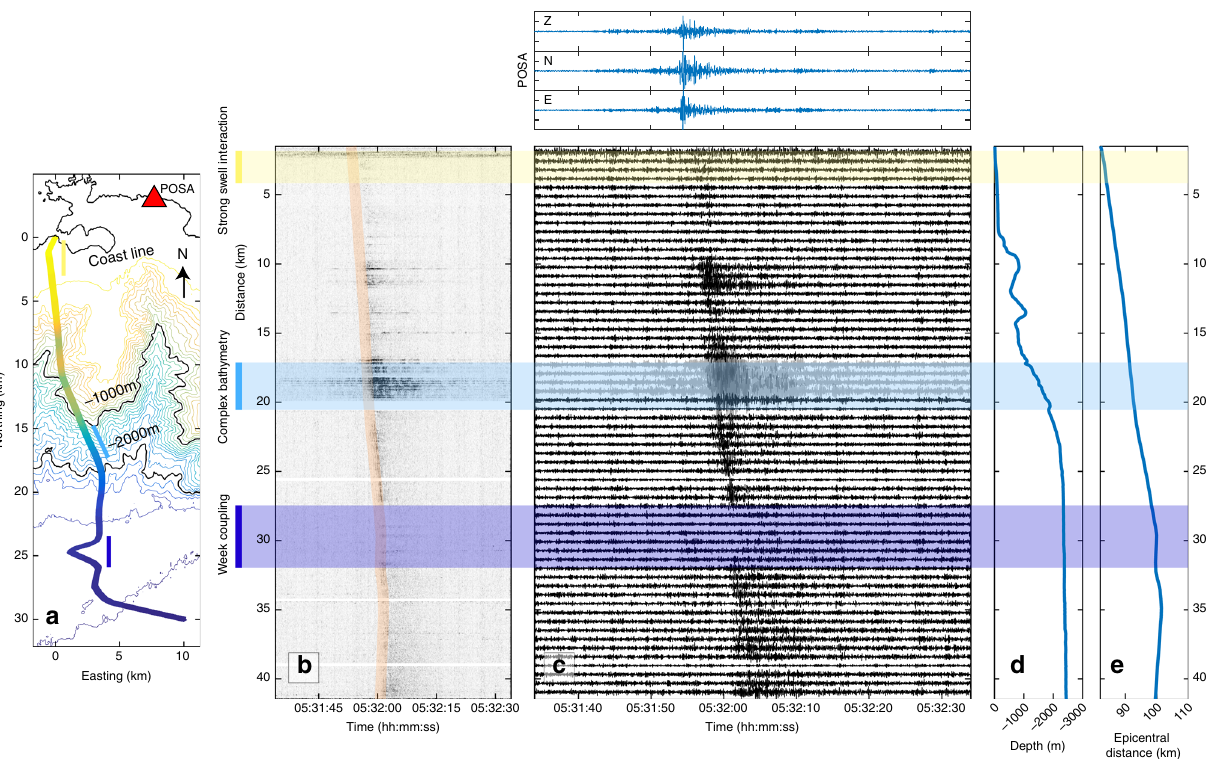
Fig. 4 Comparison of the M1.9 earthquake recorded at land station POSA and along the fi ber optic cable. a Bathymetry map of the OF cable and location of the broadband land station POSA (red triangle). DAS data are plotted either as strain-rate absolute amplitude fi ltered between 1 and 15 Hz measured every 10 m b , or as strain-rate averaged along 320 m sections of the cable c . The shaded portion in c indicates the section of cable with high ampli fi cations and where the OF cable crosses a complex bathymetry. On top are plotted for comparison the three-component records of the on-land seismic station POSA. The two plots on the right side show the cable depth and epicentral distance at different distances along the